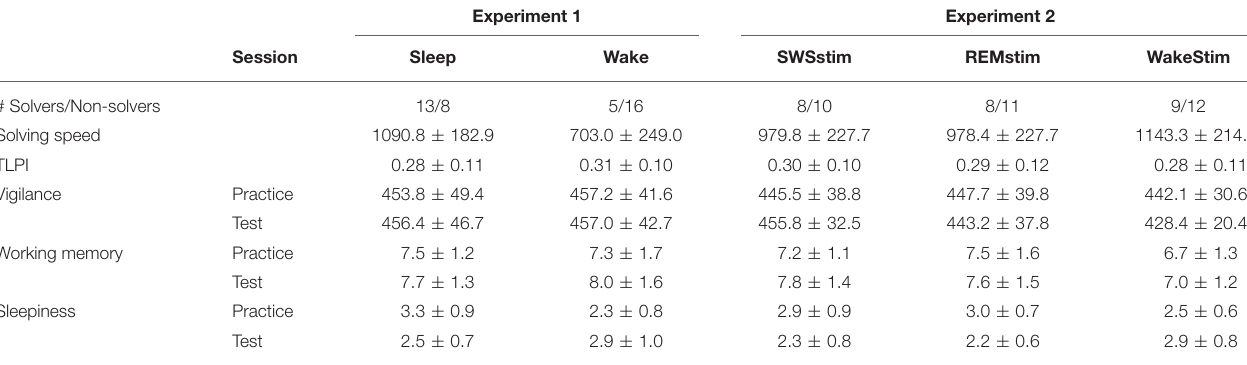
TABLE 2 | Problem solving performance and control tasks in Experiment 1 and Experiment 2.